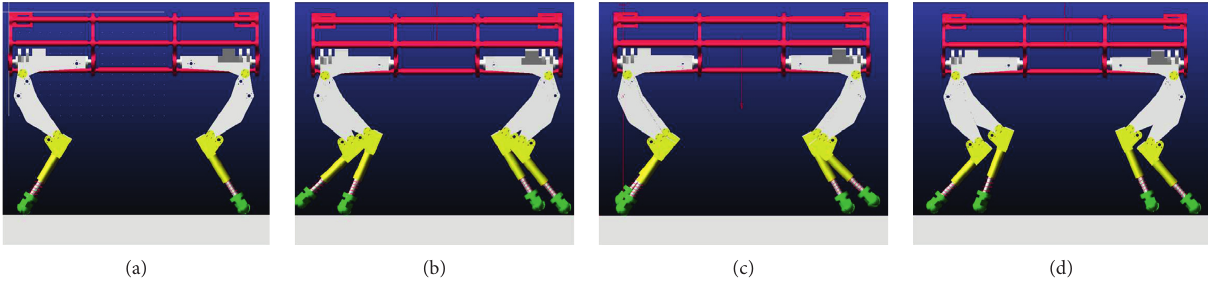
Figure 4: Robot tort gait experiment process. (a) Left hind leg lift stage. (b) The left hind leg reaches the highest point. (c) The left hind leg land stage. (d) The left hind leg landed.